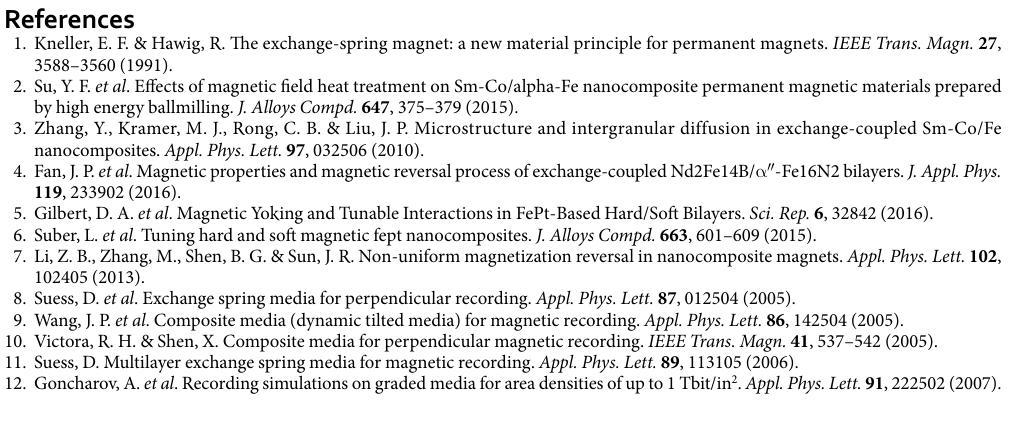
that the interface anisotropy can be either positive or negative, where a positive K int is preferred for a high rema- nence and a large energy product. Further, the formula for the nucleation field is derived analytically, which is found to be linearly related to the interface anisotropy for all calculated values of layer thickness. Therefore, a simplified linear formula for the nucleation field is educed, which is reliable for all combinations of the hard/soft layers calculated. The influence of the interface anisotropy is more significant for smaller soft layer thickness, where the interface anisotropy can change the nucleation field by more than 90% in comparison with that for K int = 0. In addition, the microscopic hysteresis loops for θ h , θ 0 and θ s as well as the angular distributions in the thickness direction are calculated numerically, which shows that the effect of the interface anisotropy on the angles is not signifi- cant. In particular, the angular distributions are the same for different values of the interface anisotropy at the pinning field. In summary, neither the coercivity nor the angular distributions of exchange-coupled magnets are sensitive to the interface anisotropy. However, the nucleation field and the energy product are quite sensitive to the interface anisotropy, especially for small soft layer thickness. The positive interface anisotropy enhances the nucleation field, the remanence and the energy product, whereas the negative anisotropy deteriorates all these properties. Therefore, it is important to have the positive interface anisotropy in experiments, where small layer thickness is preferred for a giant energy product to be realized in exchange-coupled multilayers.